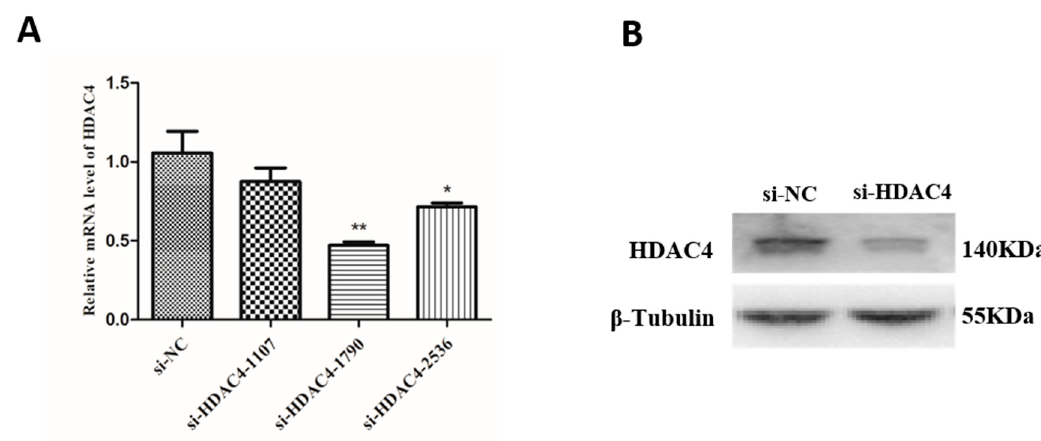
Figure 2. Confirmation of interference efficiency of the HDAC4 gene. ( A ) The relative mRNA level of HDAC4 in skeletal muscle satellite cells (SMSCs) after being transfected with three siRNA (si-HDAC4-1107, si-HDAC4-1709, and si-HDAC4-2536) and si-NC. ( B ) The protein expression level of HDAC4 after interference by si-HDAC4 was detected by western blotting. In all panels, the values represent mean ± SEM from three independent experiments. * p < 0.05; ** p < 0.01.